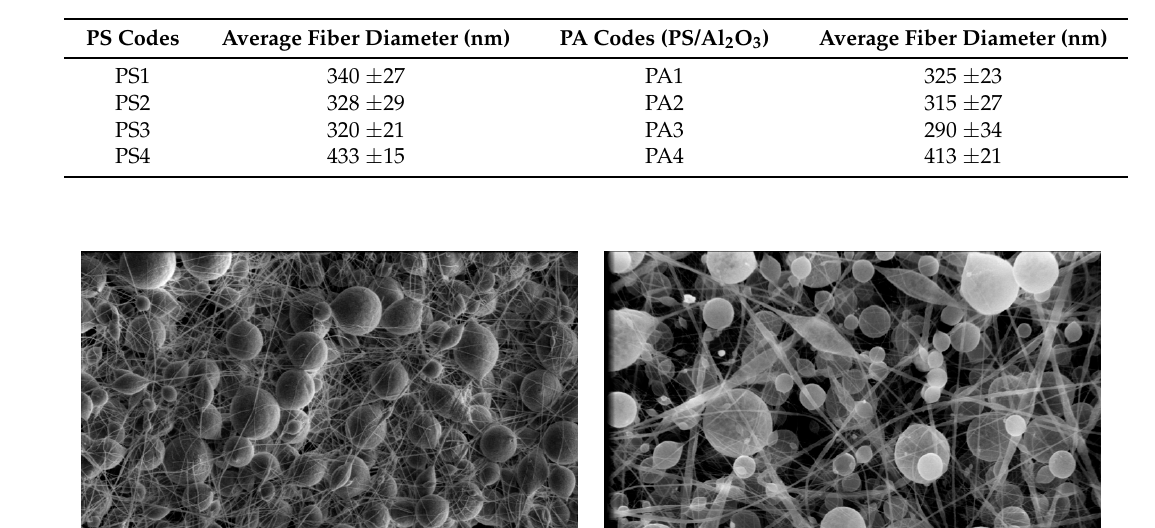
Table 2. The average diameter of the nanofibers and beads of PS and PS/Al 2 O 3 nanocomposite coatings.